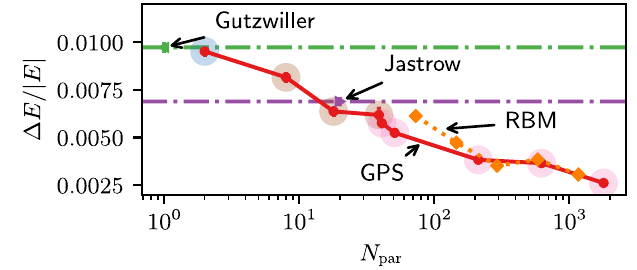
FIG. 7. Energy errors obtained for the bootstrapped GPS for the half-filled 6 × 6 2D square Hubbard lattice at U ¼ 8 t (compared to benchmark AFQMC values [44]), plotted against the number of variational parameters (excluding those in the Pfaffian state). Results are systematically improved via use of a more complex kernel or a decrease of the ˜ σ 2 regularization parameter, which increases the chosen data-set size. The GPS with blue back- ground shading was obtained with the k ð 1 Þ kernel; values with brown shading correspond to the p → ∞ kernel, where the distance weighting was fixed at f ð d Þ ¼ 1 = j d j and θ was varia- tionally optimized; for the pink highlighted results, all scaled distance hyperparameters f ð d Þ = θ were optimized variationally 35 variational parameters). Also displayed for (giving N b þ comparison are the energy errors obtained with the Gutzwiller, Jastrow, and RBM ansatzes (with α chosen as 1, 2, 4, 8, and 16). Each of these displayed comparison values corresponds to the lowest energy obtained for repeated calculations with five differ- ent random